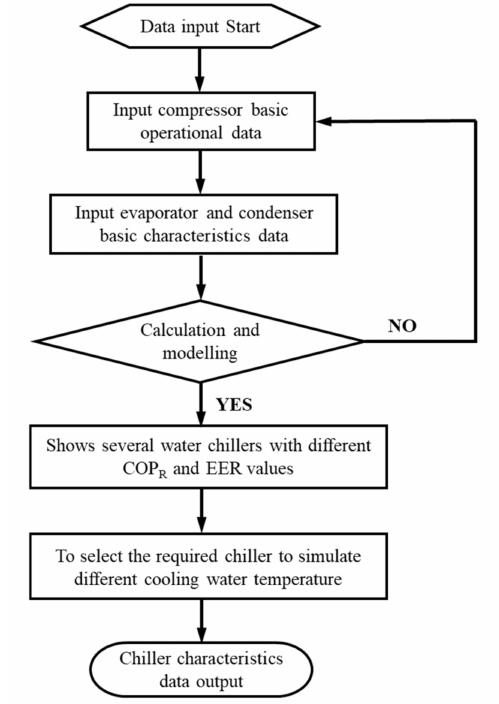
Figure 6. Flow chart of the operational analysis of the chiller characteristic